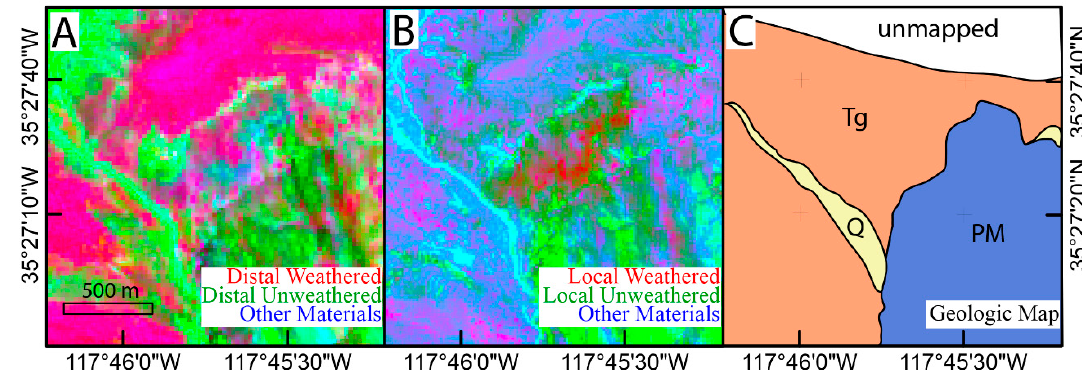
Figure 8. Spectral unmixing of Goler Sentinel-2 data with both resampled endmembers from the Maniobra field site ( A ), locally derived endmembers ( B ), and geologic map after [56] ( C ). As in the comparative matrix shown in Figure 6, local endmembers provide greater detail than distal endmembers, in this case allowing discrimination between the basal and not basal subunits of the Goler Formation.